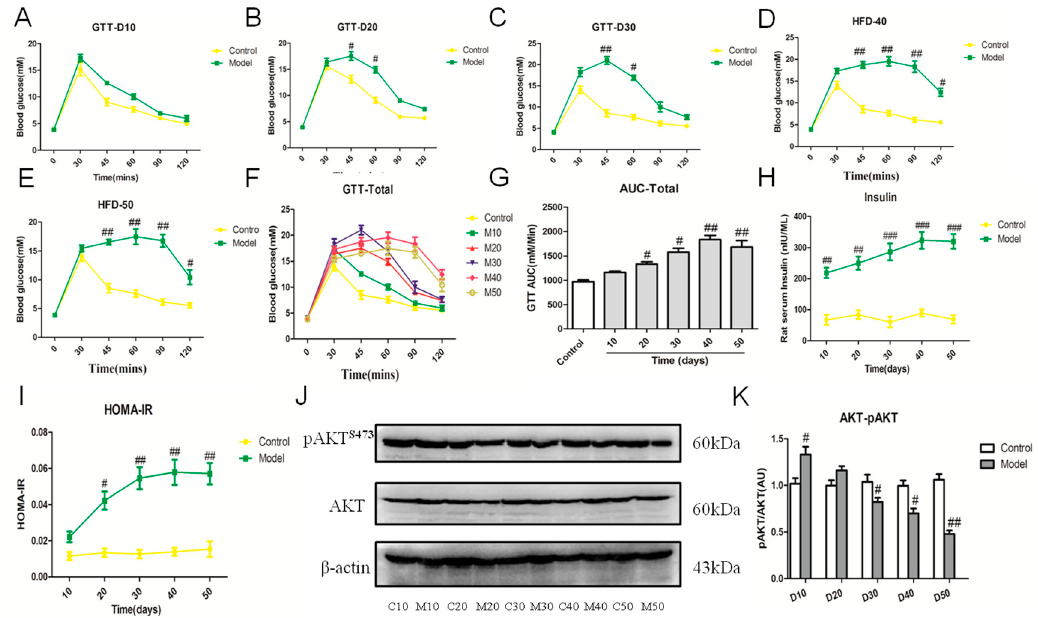
Figure 6. High fat-sucrose diet accelerated insulin resistance in NASH rats. The hepatic insulin resistant of SD rats induced by the high fat-sucrose diet on day 10, 20, 30, 40, 50. The blood glucose concentration of day 10 ( A ); day 20 ( B ); day 30 ( C ); day 40 ( D ); day 50 ( E ); total period (F); Area under the cure (AUC) of total ( G ). Serum insulin content ( H ). Homeostasis model assessment index of insulin resistance (HOMA-IR) ( I ). The protein expression of phospho-AKT (Ser473) (pAKT ser473 ) and protein kinase B (AKT) ( J ). Semi-quantitative of pAKT ser473 and AKT protein expression ( K ). The values are expressed as the means ± SEM ( n = 6). Compared with the corresponding control group, # p < 0.05, ## p < 0.01, ### p < 0.001.